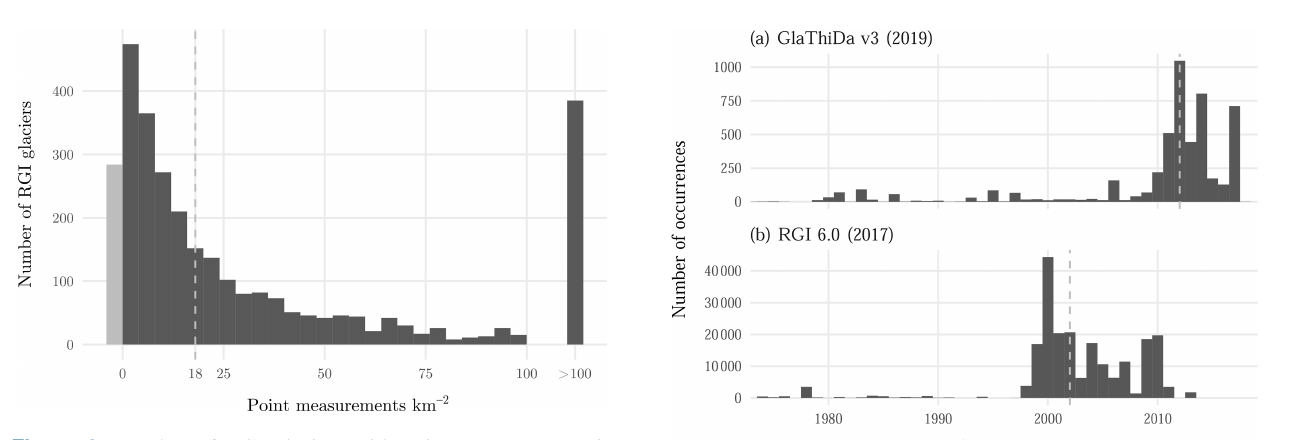
Figure 8. Number of RGI glaciers with point measurements in GlaThiDa by the average number of point measurements per square kilometer. The median (18 points km − 2 ) is marked with a grey dashed line. Glaciers with a mean or maximum thickness but no point measurements are shown in the grey bar to the left of 0km − 2 .